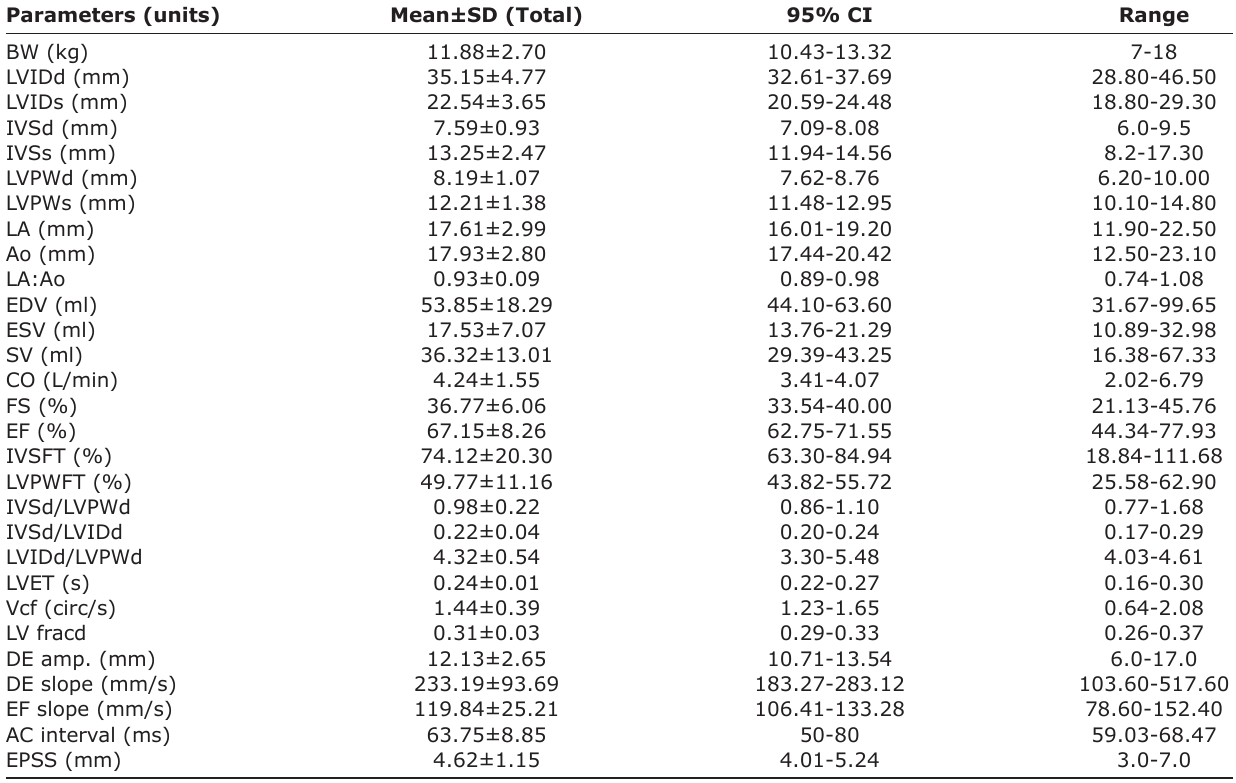
Table-1: M-mode echocardiographic measurements in Indian Spitz dogs. Parameters